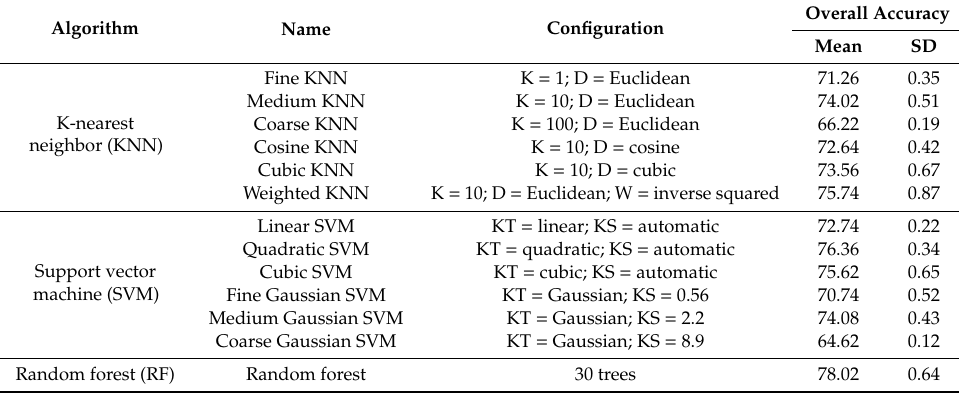
Table A4. Model presets and overall accuracy results using five-fold cross validation by algorithm (i.e., K-nearest neighbor, support vector machine, and random forest models) for the supratidal / upland zone for the contemporary habitat model development for Dauphin Island, Alabama, USA. D: Distance; K = Number of neighbors; KT: Kernel type; KS: Kernel scale; SD: Standard deviation; and W: